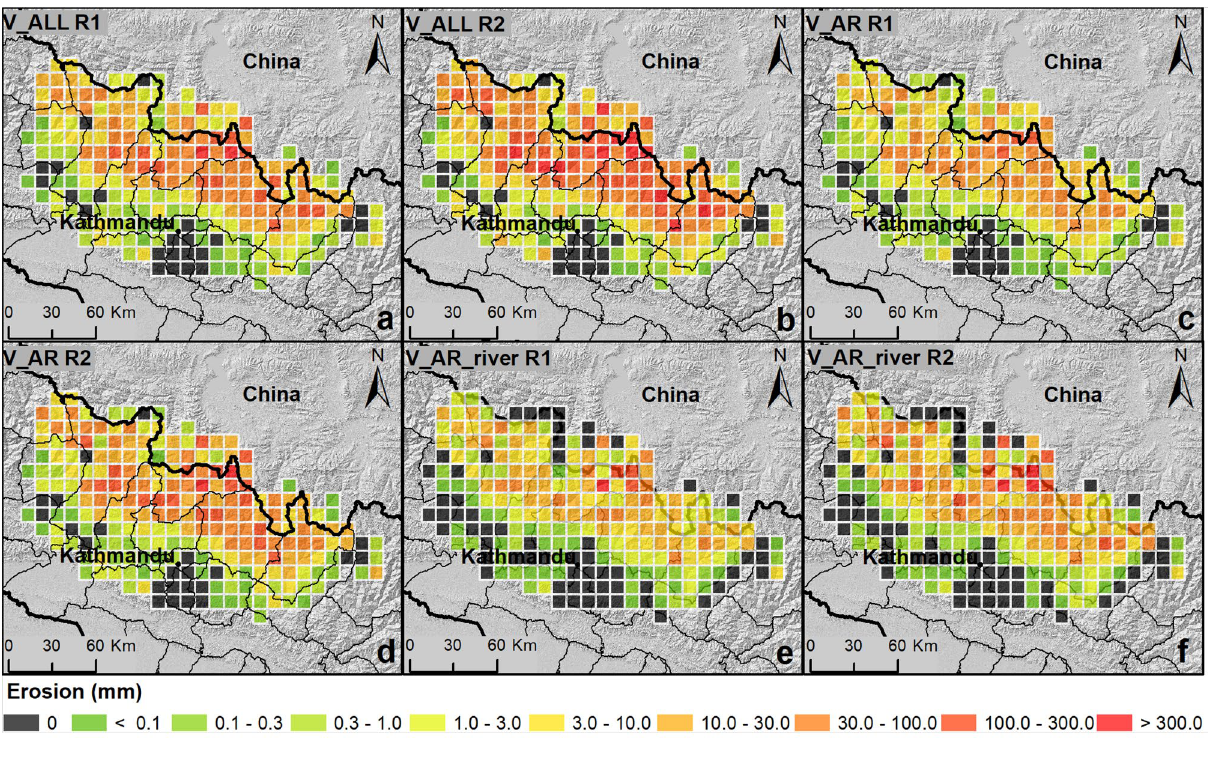
Figure 3. erosion (E cell ) computed for the 235, 10 km x10km, lattice cells. ( a , b ) Mean erosion for V_ALL: the volume is calculated from the entire landslide area with R1 (global relationship for all landslides) and R2 (relationship for Himalayan landslides), respectively (see Supplementary Table S2). ( c , d ) Mean erosion for V_AR. The landslides volume was calculated with R1 and R2, respectively; ( e , f ) mean erosion for landslides that overlap the river network, V_AR_river, again with R1 and R2, respectively. For the scar area both R1 and R2 were applied. For V_AR and V_AR_river, the volume eroded from the runout area is computed